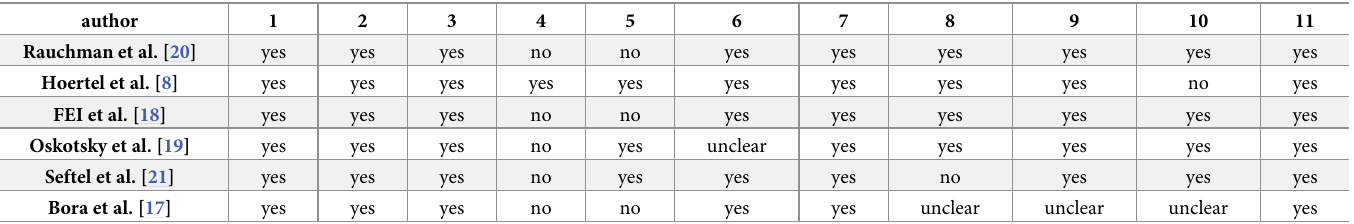
Table 2. Quality assessment of cohort studies.